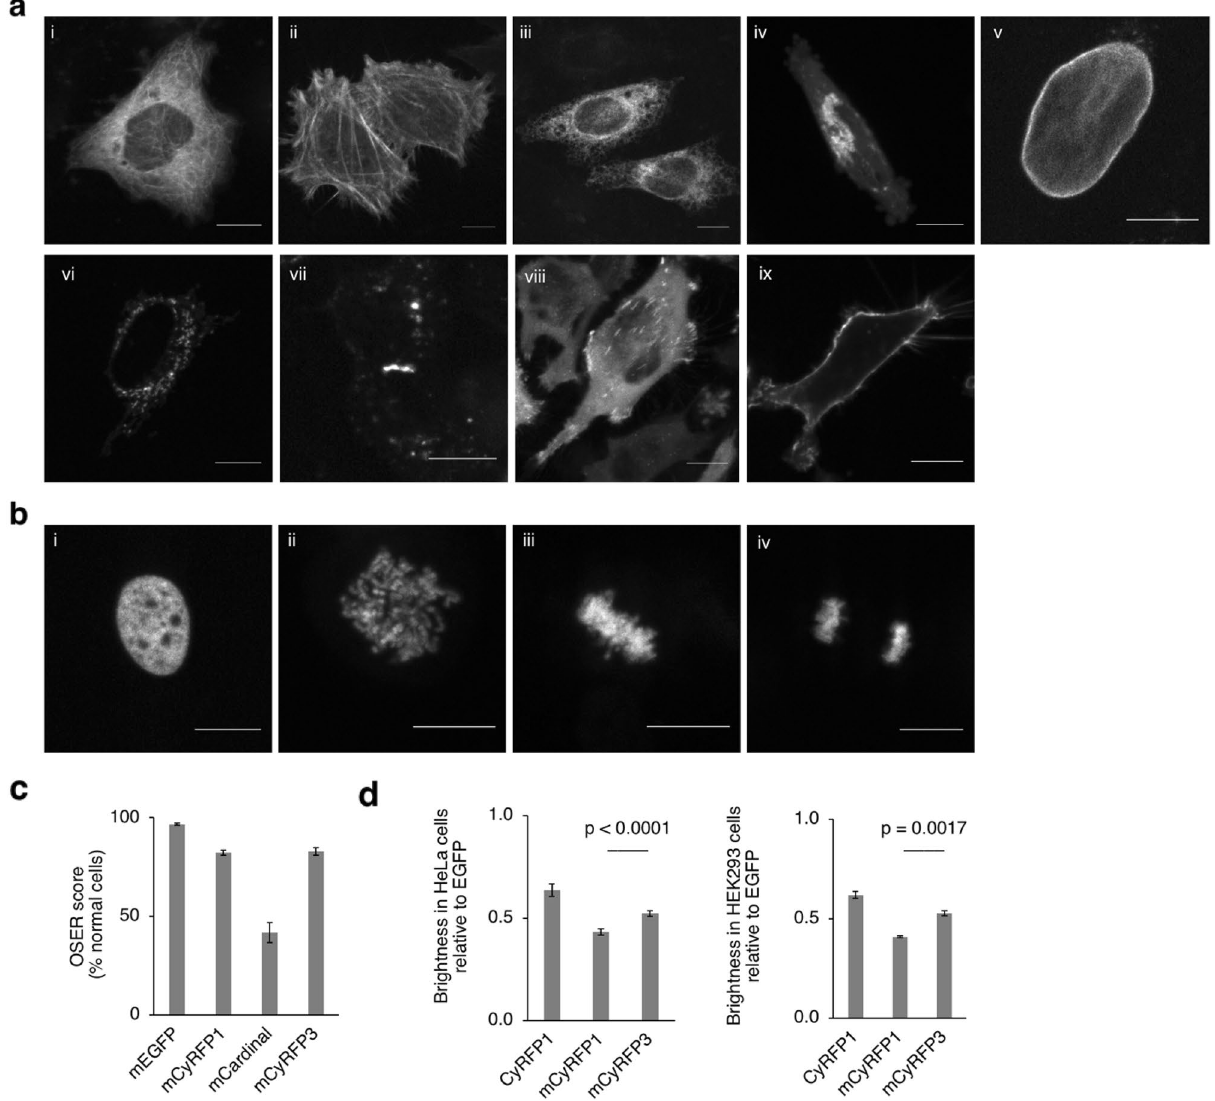
Figure 2. Performance of mCyRFP3 in mammalian cells. ( a ) HeLa cells expressing mCyRFP3 fused various subcellular proteins. For each fusion, the original of the fusion partner and its normal subcellular location are indicated in parentheses. (i) mCyRFP3-2aa-tubulin (human, microtubules), (ii) mCyRFP3-7aa-actin (human, actin cytoskeleton), (iii) Calnexin-14aa-mCyRFP3 (human, endoplasmic reticulum), (iv) mannosidaseII-10aa- mCyRFP3 (mouse, Golgi complex), (v) mCyRFP3-10aa-lamin B1 (human, nuclear envelope) (vi) PDHA-10aa- mCyRFP3 (human, mitochondrial pyruvate dehydrogenase), (vii) connexin43-7aa-mCyRFP3 (rat, cell–cell adhesion junctions), (viii) paxillin-22aa-mCyRFP3 (chicken, focal adhesions), (ix). mCyRFP3-2aa-CAAX. Scale bar, 10 µm. ( b ) mCyRFP3-10aa-H2B (human, nucleosomes) in (i) interphase, (ii) prophase, (iii) metaphase, (iv) anaphase. Spinning-disk confocal image stacks were acquired using Improvision Volocity 6.0 and flattened and scaled in NIH Fiji 2.1. ( c ) Performance of mCyRFP3 compared to mCyRFP1, mEGFP and mCardinal